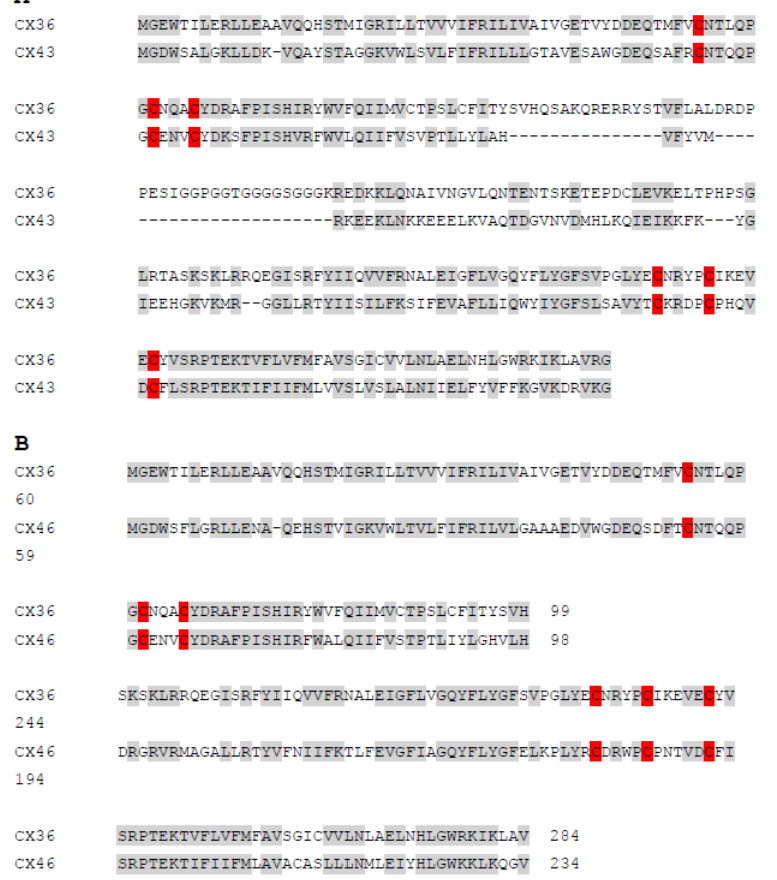
Figure 6. Human CX36 amino-acid sequence alignment with CX43 ( A ) and CX46 ( B ); identical and similar amino acids are depicted in grey, Cys residues-potential targets to redox modifications are highlighted in red; the primary amino-acid sequences were aligned using protein blast tool available at https://blast.ncbi.nlm.nih.gov/Blast.cgi, accessed on 23 January 2021. Table 1. Dysregulated genes of redox-regulating proteins in type 2 diabetes mellitus (T2D) pa- tients. Gene Symbol